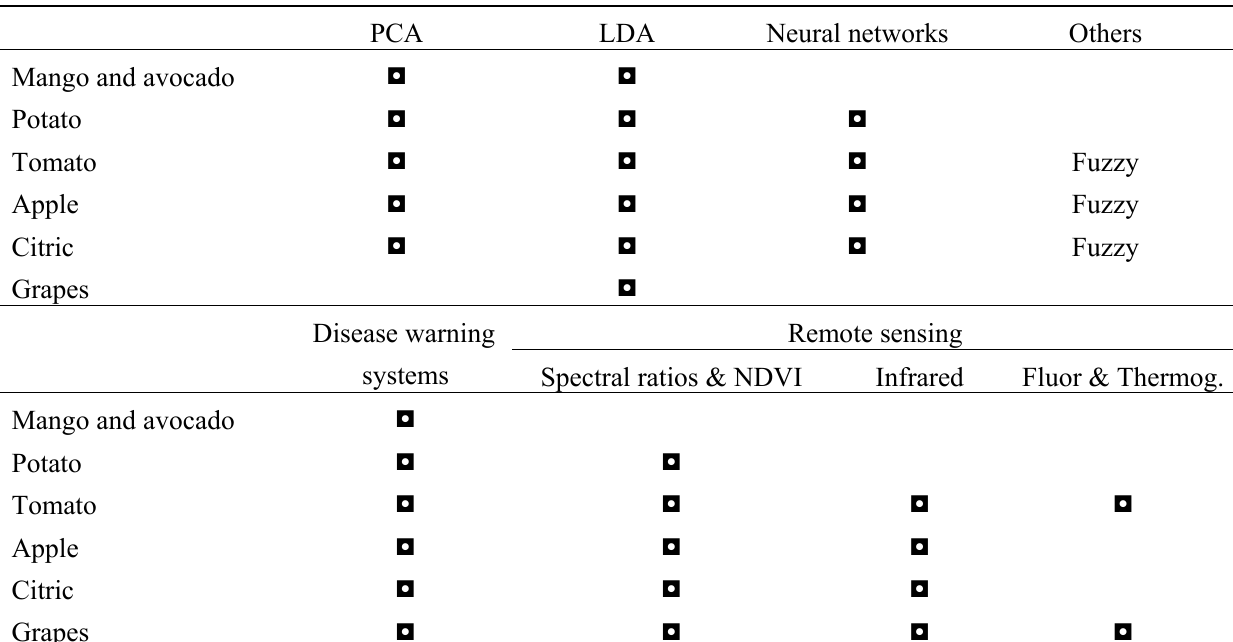
Table 4. Algorithms used for the different operations on